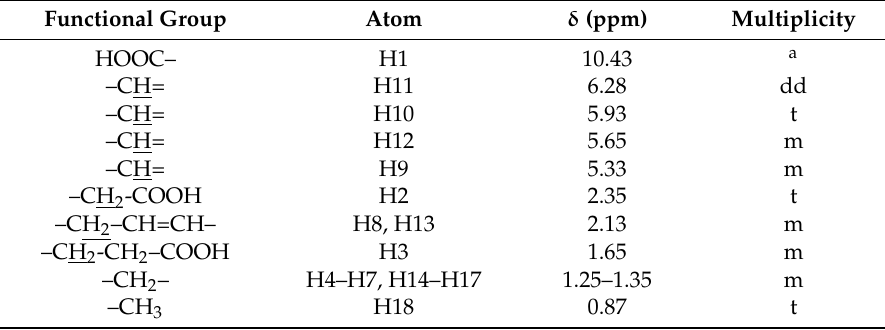
Figure 17. Selected region of 500 MHz 2D 1 H- 1 H TOCSY NMR spectrum of (9- cis , 11- trans ) 18:2 CLA (solution conditions the same as in Figure 16). Mixing time τ m = 100 ms, number of scans (ns) = 16, number of increments = 256, total experimental time = 2 h 39 min. Table 18. 1 H-NMR peak assignments of the (9- cis , 11- trans ) 18:2 CLA in CDCl 3 .